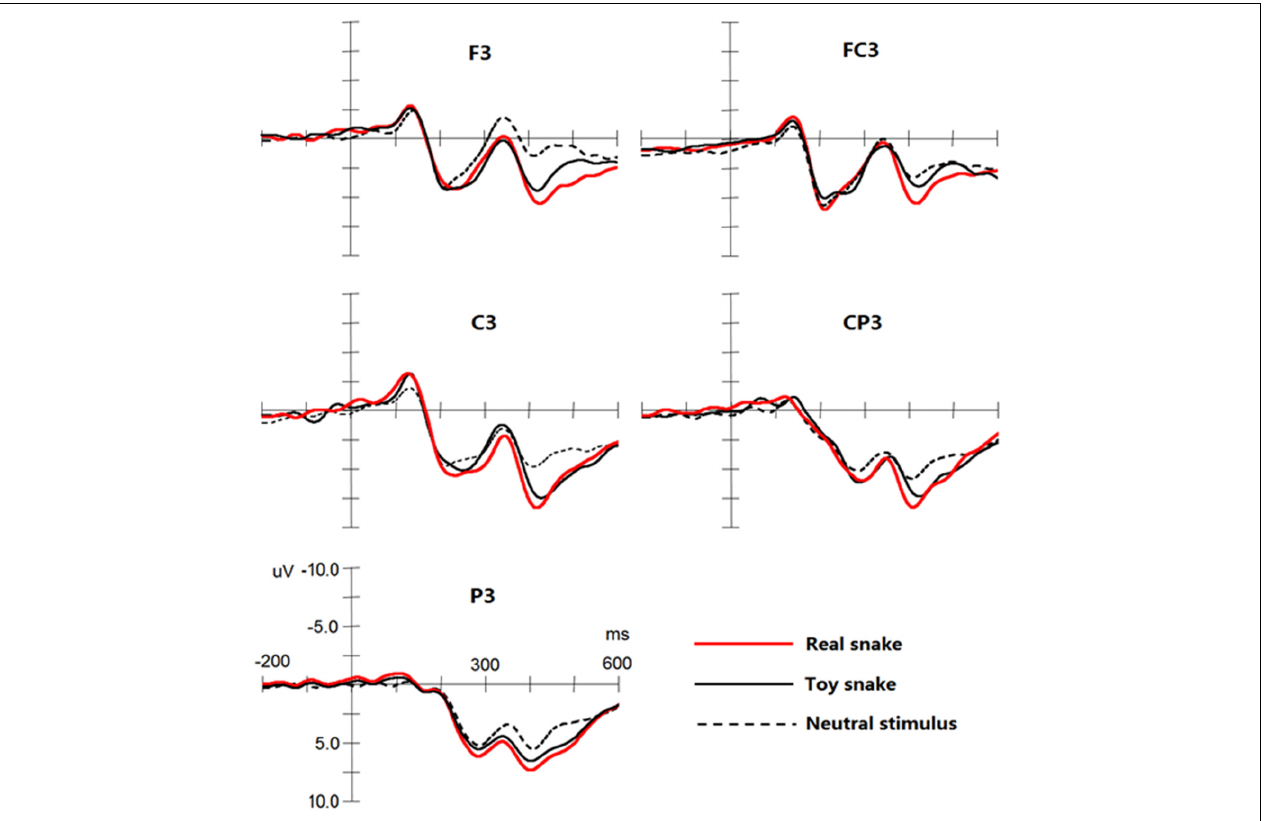
FIGURE 3 | Event-related potential (ERP) components elicited by a real snake, toy snake, and neutral stimuli at the F3, FC3, C3, CP3, and P3 electrodes.